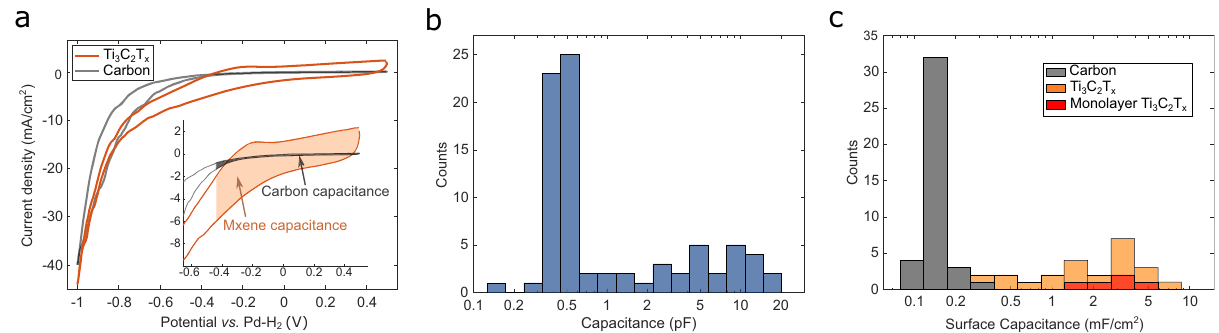
Fig. 2 | Capacitive response on monolayer MXene fl akes and surrounding car- bon substrate. a Representative cyclic voltammograms over a carbon surface (black) and a single monolayer MXene fl ake (orange) at scan rate of 0.5V/s in 20mMHClO 4 . b HistogramofthecapacitanceateachindividualSECCMgridpoint